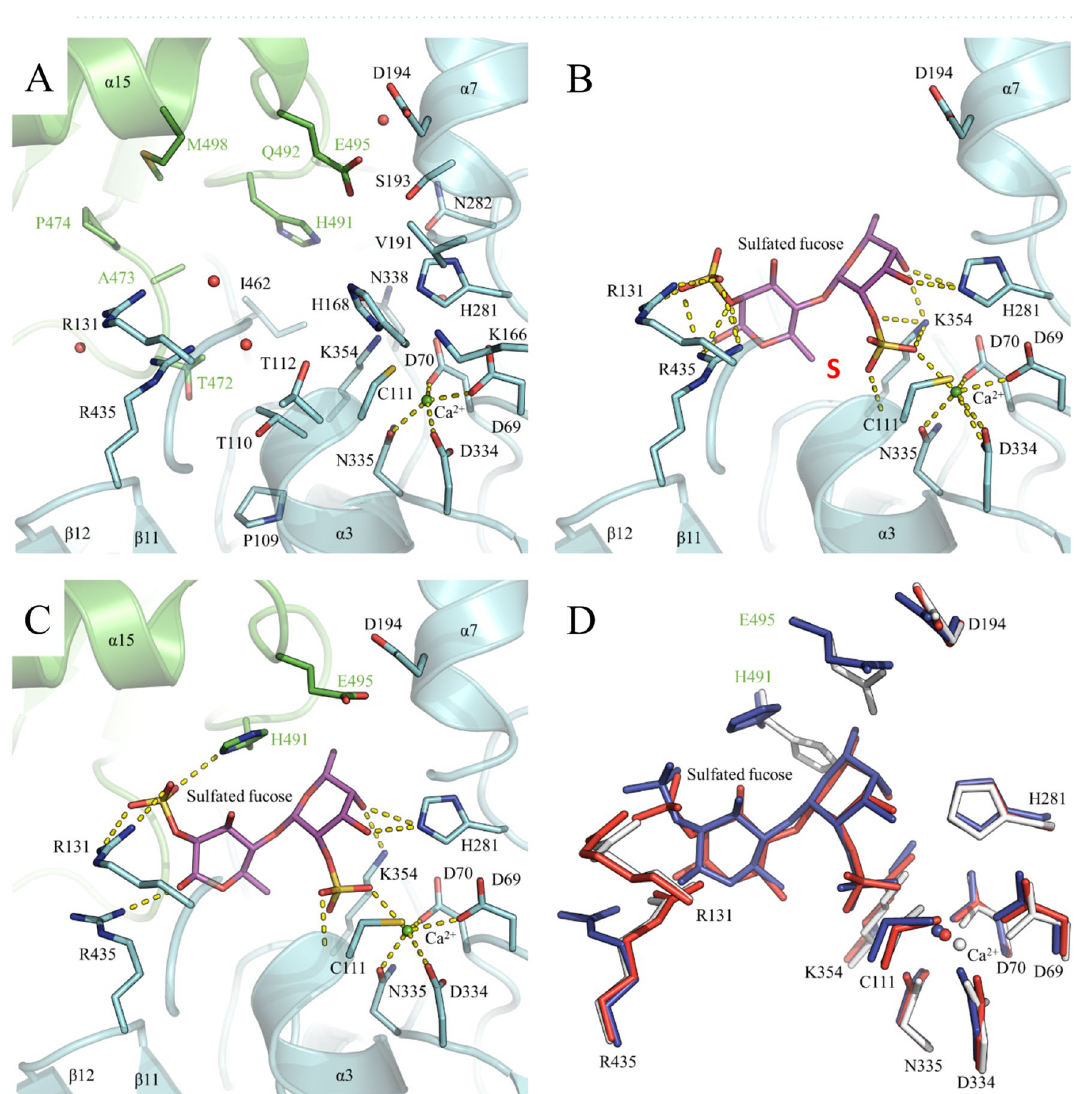
Figure 3. Docking results of sugar-sulfatase complexes and PsFucS1 activity on fucoidan. ( A ) Active site pocket of PsFucS1 X-ray crystal structure. ( B ) Cartoon representation of C2 sulfated fucobiose-PsFucS1 complex obtained by docking. The red S indicates the position of the sulfate binding site as defined by Hettle et al. 2018 18 . ( C ) Zoomed-in view of PsFucS1 active site with docked disaccharide at the dimer interface. ( A – C ) Monomers A and B are colored in green and cyan, respectively. Residues constituting the binding pocket are pointed as sticks and those from monomer A are labeled in green. Secondary structure elements are shown as cartoon. The calcium atom and water molecules are shown as green and red spheres, respectively. The bound disaccharide into the active site pocket is shown as purple sticks. H bonds between the ligand and protein are yellow dotted lines. ( D ) Superposition of the PsFucS1 X-ray crystal structure (white) to the monomer docked model (red) and the dimer docked model